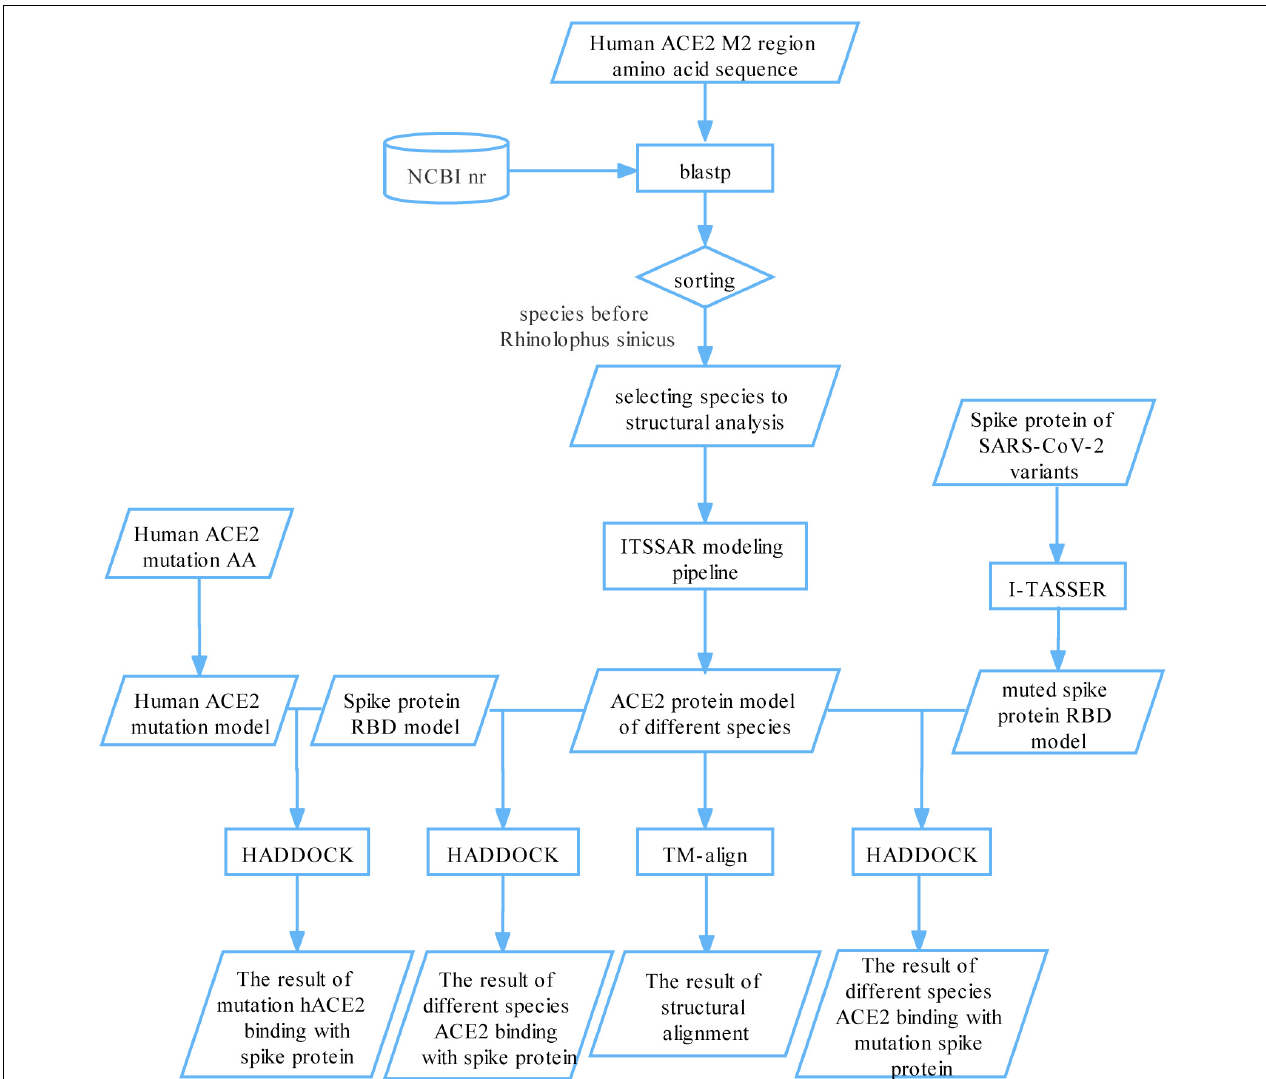
FIGURE 1 | A bioinformatics framework for systematically tracing susceptible animals to SARS-CoV-2. First, we aligned the amino acids sequence of the M2 region of hACE2 protein against the NCBI nr database and selected 31 species for structural modeling and binding their ACE2 protein with SARS-CoV-2 spike protein. The binding scores of ferret, cat, and tiger were setting as a threshold to find susceptible animals to SARS-CoV-2. Second, we analyzed the binding sites of a few representative species to explain how the spike proteins interact with their ACE2 proteins. Finally, we simulated some mutations on human ACE2 protein and viral spike protein and calculated the binding affinity between mutated/un-mutated ACE2 proteins and mutated/un-mutated viral spike proteins.